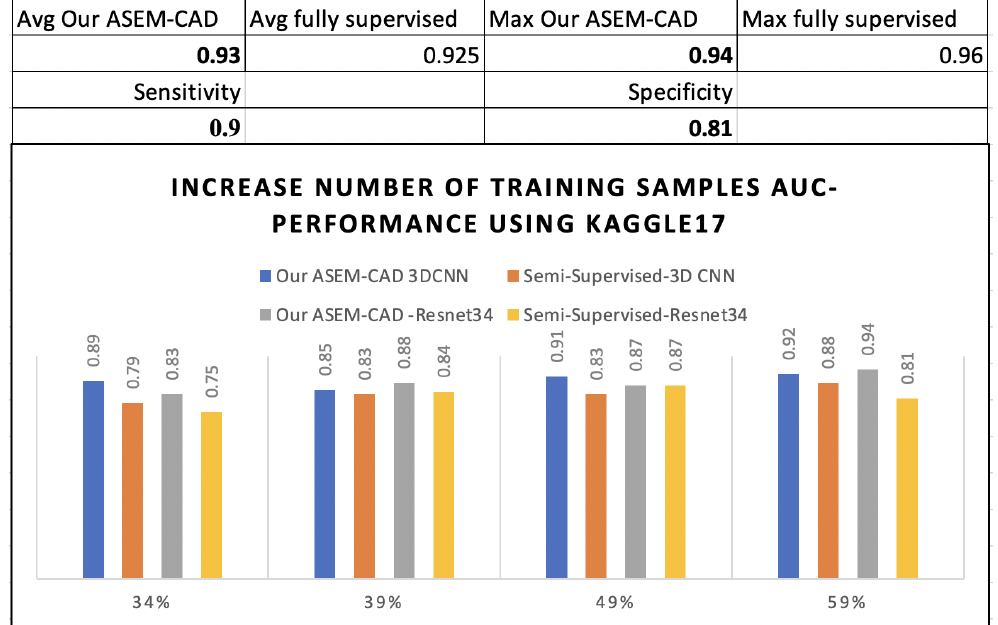
Figure 7. Comparison of algorithms with an increasing number of samples for training.